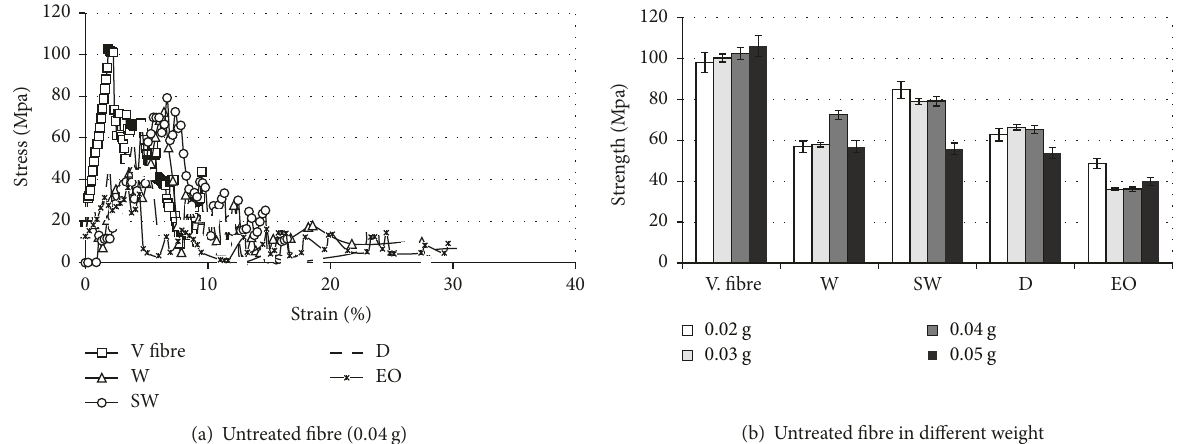
Figure 2: Tensile behaviour of untreated kenaf fibres with different solution.